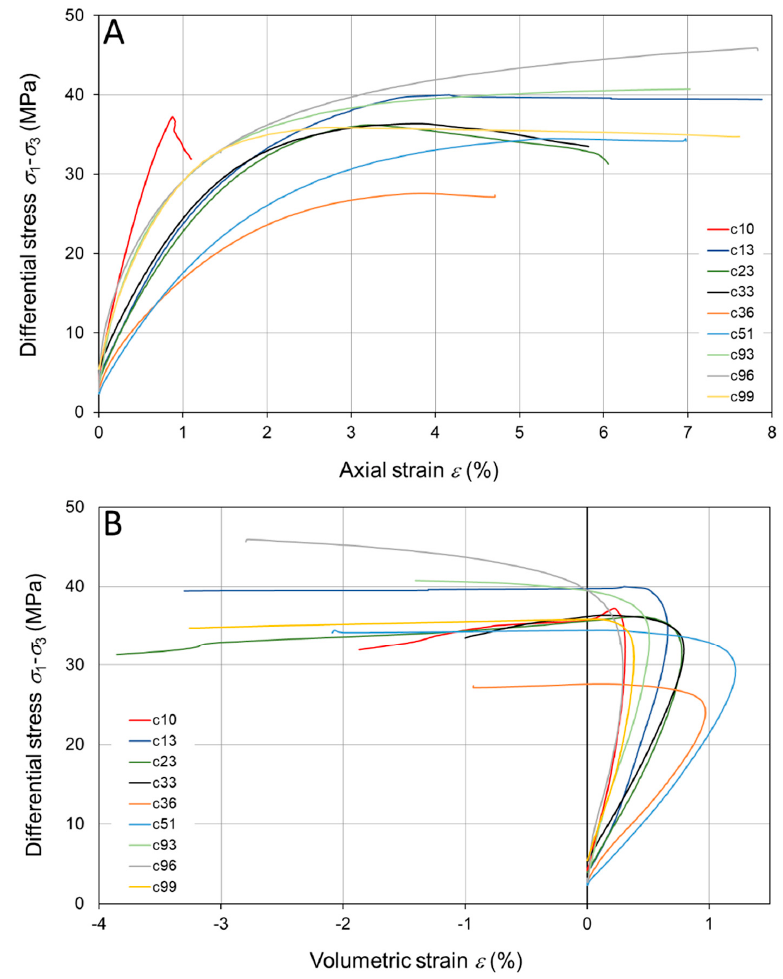
Figure 14. Stress–strain characteristics of the Red Zuber unit samples in the tests at a constant strain rate. ( A )—axial strain; ( B )—volumetric strain (according to [57]). The maximum values of differential stress and axial strain are presented in Table 2. The detailed results of the short-term compression tests are presented in Table A1. Table 2. Maximum values of differential stress ( σ 1 – σ 3 ) and axial strain ( ε 1 ) obtained in the conventional triaxial compression tests.